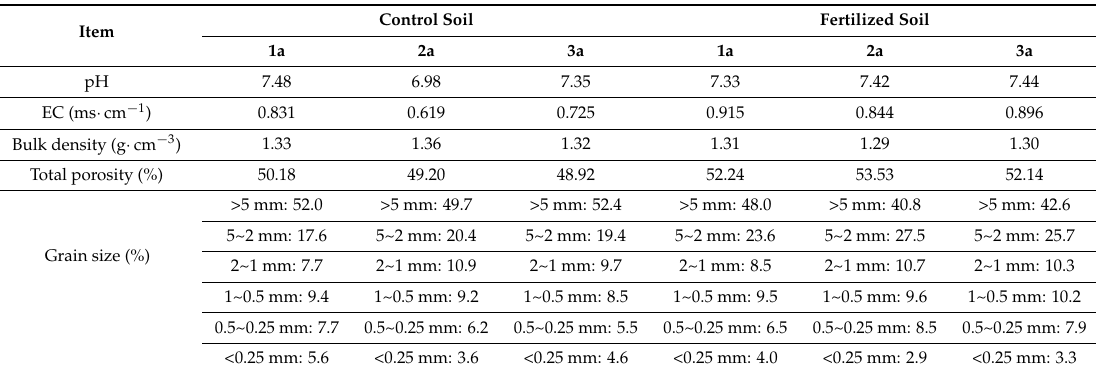
Table 2. Physical properties of control and fertilized soils.